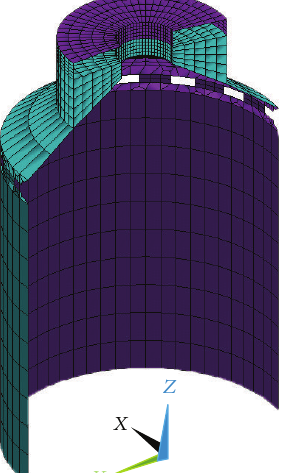
Figure 2: The shield building mesh viewed by partial section.